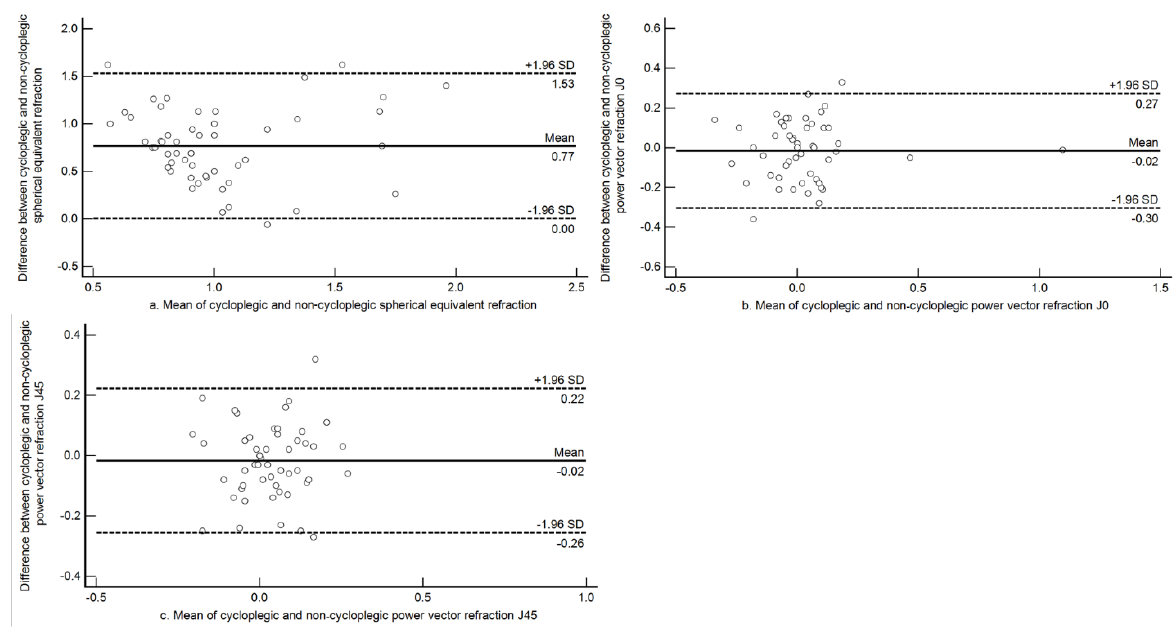
Figure 3. Bland-Altman plots assessing agreement between cycloplegic and non-cycloplegic refraction estimates for spherical equivalent refraction, J0 and J45 among subjects with hyperopia of greater than +1.00 D. ( a ) Agreement between cycloplegic and non-cycloplegic refraction for M; ( b ) agreement between cycloplegic and non-cycloplegic refraction for J0; ( c ) agreement between cycloplegic and non-cycloplegic refraction for J45. The central solid line represents the mean difference between the two measurements and the broken lines above and below represents the 95% Limits of Agreement.